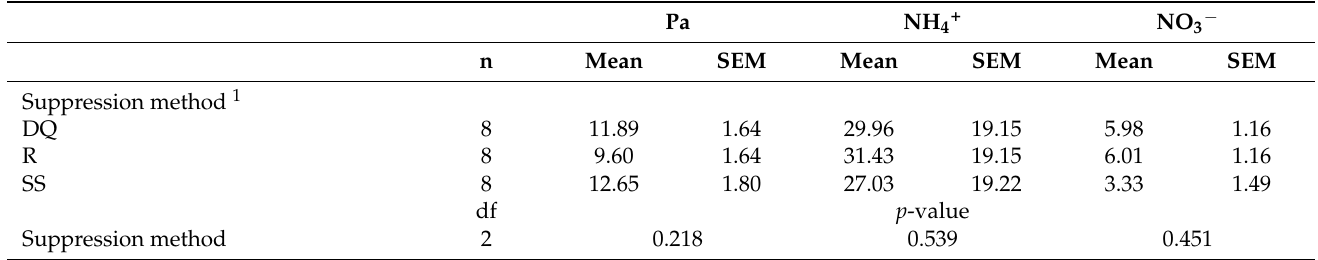
Table 1. Treatment mean values (mean), standard errors of the mean (SEM), number of observations (n), as well as probability values ( p -value), and degrees of freedom (df) associated with the ANOVA of available phosphorus (Pa), ammonium (NH 4+ ) and nitrate (NO 3 −